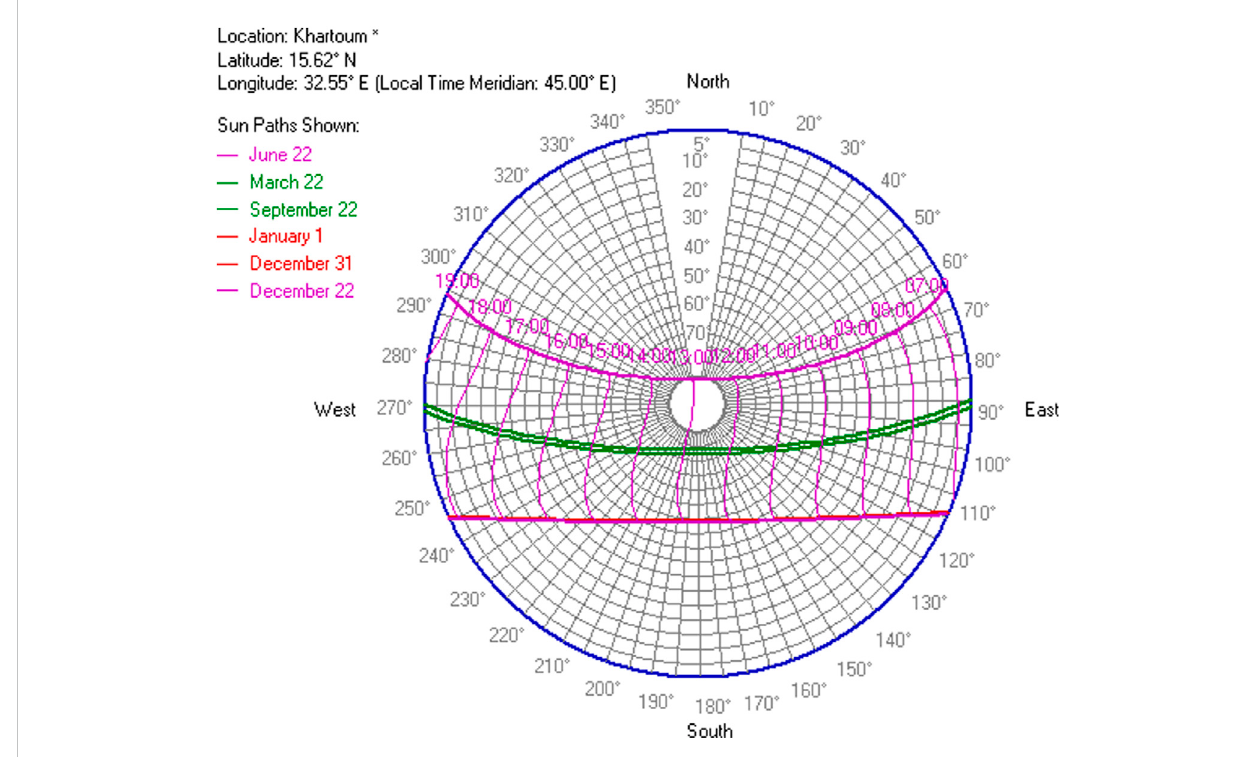
FIGURE 5 Sun path in